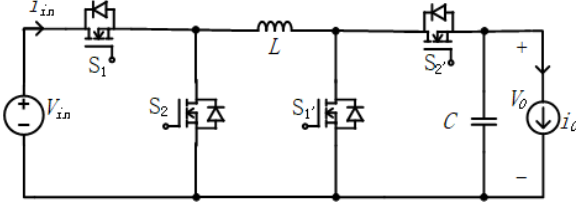
Figure 9. A voltage-fed buck-boost converter.